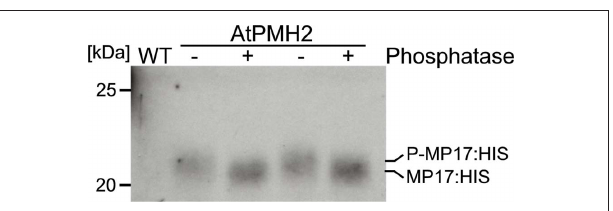
FiguRe 4 | Affinity purification of MP17:HiS. (A) Purification strategy of MP17:HIS; ATPMH2 rosettes were homogenized in NP40-buffer and soluble (1) and insoluble fractions were separated by centrifugation; the insoluble fraction was washed four times to reduce unspecific binding (last supernatant = 2); the insoluble fraction was subsequently extracted with urea and the urea insoluble (3) and soluble fraction (4) were separated by centrifugation; the soluble fraction